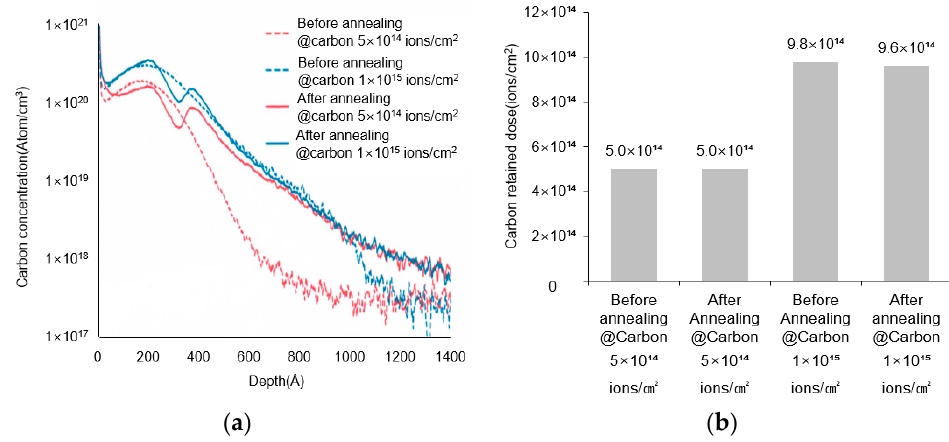
Figure 3. ( a ) SIMS profile of carbon concentration before and after annealing. ( b ) Retained dose of carbon in the wafer.